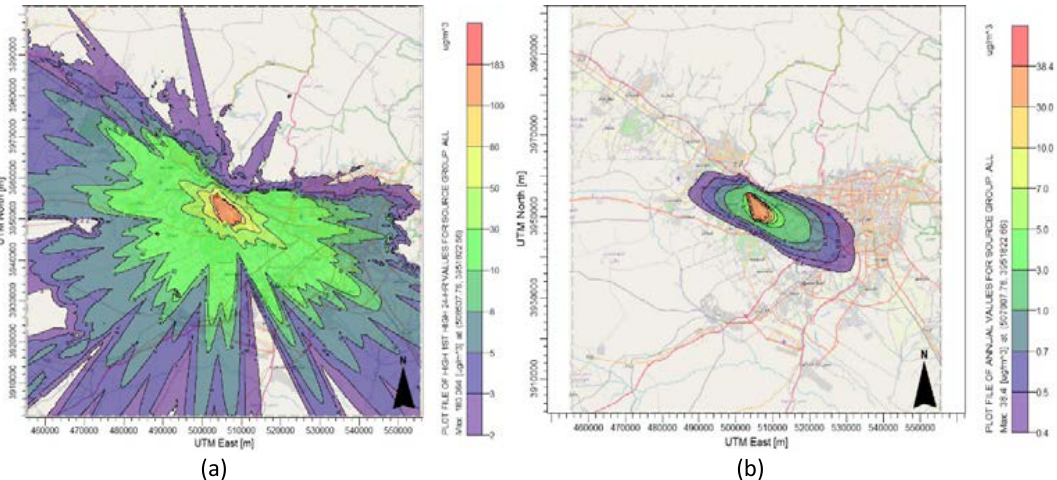
Fig. 6: Dispersion of PM 10 from the sand and gravel product plants: (a) 24-hour average and (b) annual average